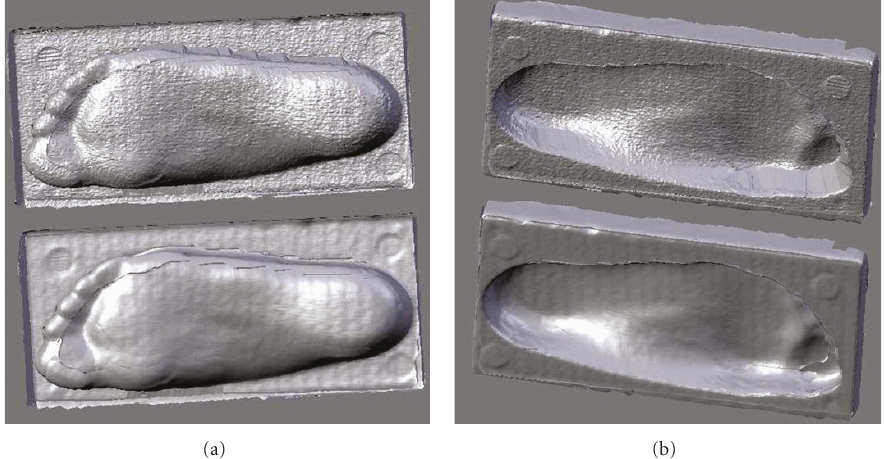
Figure 7: Reconstruction of a foam box from the multiple views. The results are shown from two perspectives ((a) and (b)). In addition, the top parts of the figure show the 3D raw data and the bottom parts represent the smoothed